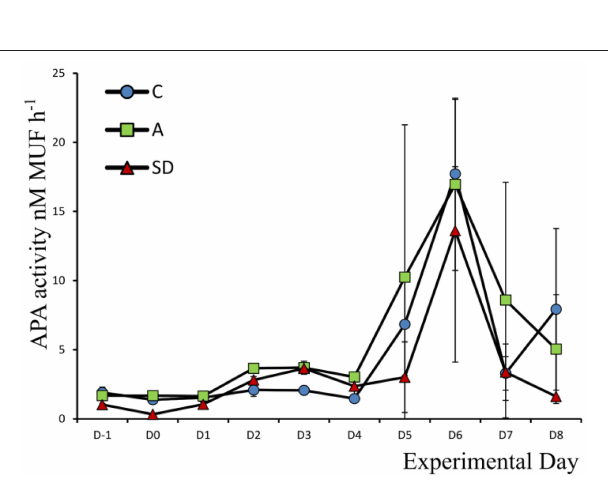
FIGURE 5 | Alkaline phosphatase activity in each treatment.